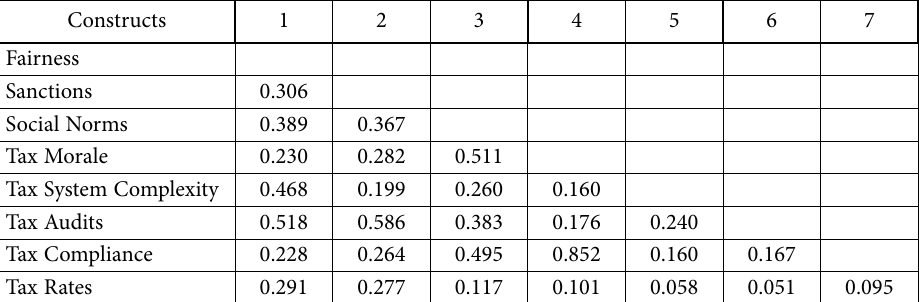
Table 5. Heterotrait-monotrait